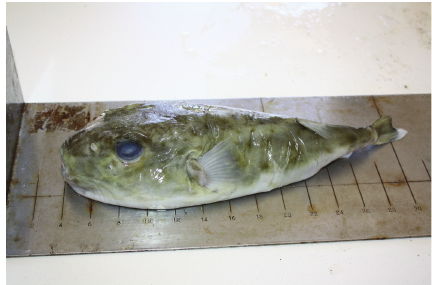
Figure 1: Area of discovery: Strait of Messina. Table 1: Morphometric measurements (in mm and F% of TL) and meristic counts of S. pachygaster caught in the Strait of Messina.